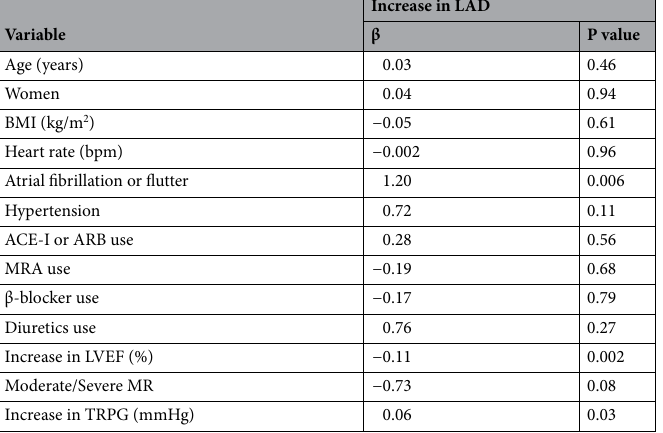
Table 2. Multiple linear regression analysis for increase in LAD. Diuretics included loop diuretic, thiazide and tolvaptan. LAD, left atrial diameter; BMI, body mass index; ACE-I, angiotensin-converting enzyme inhibitor; ARB, angiotensin-receptor blocker; MRA, mineralocorticoid receptor antagonist; LVEF, left ventricular ejection fraction; MR, mitral regurgitation; TRPG, tricuspid regurgitation pressure gradient.